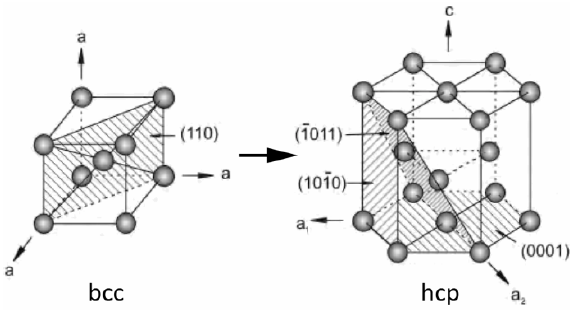
Figure 9. Crystal structure variation of martensite transformation (from bcc to hcp).